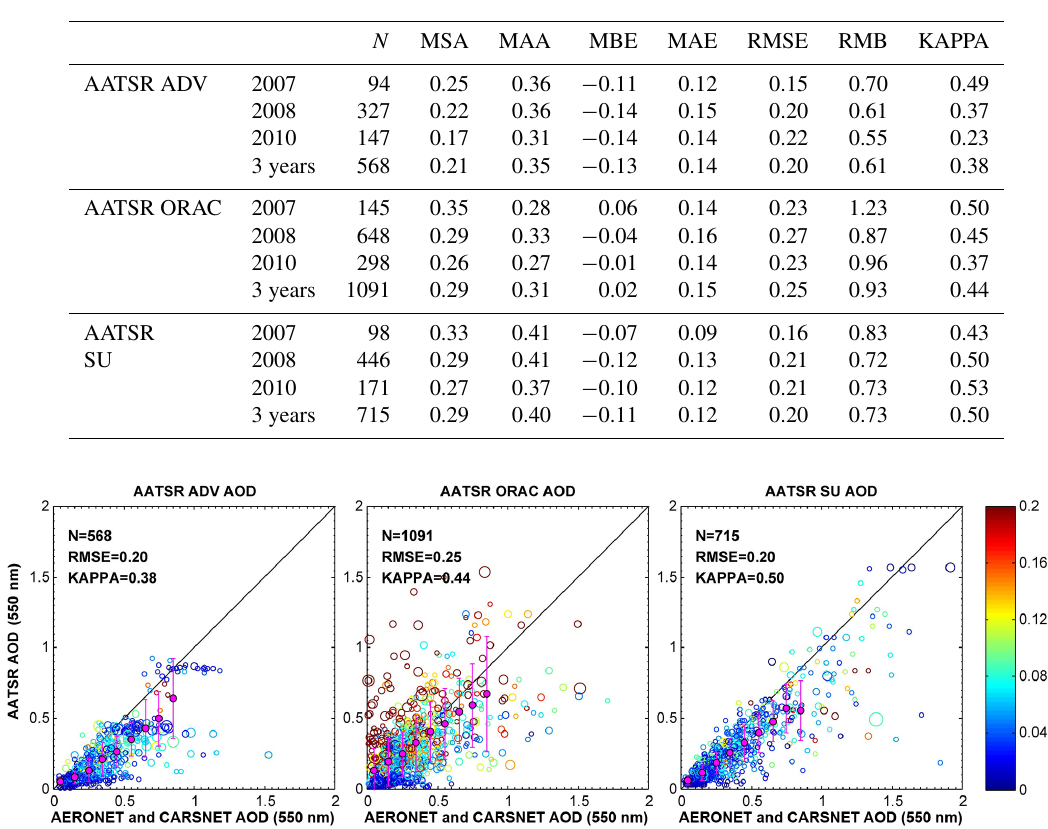
Table 4. Main statistics of the validation results.